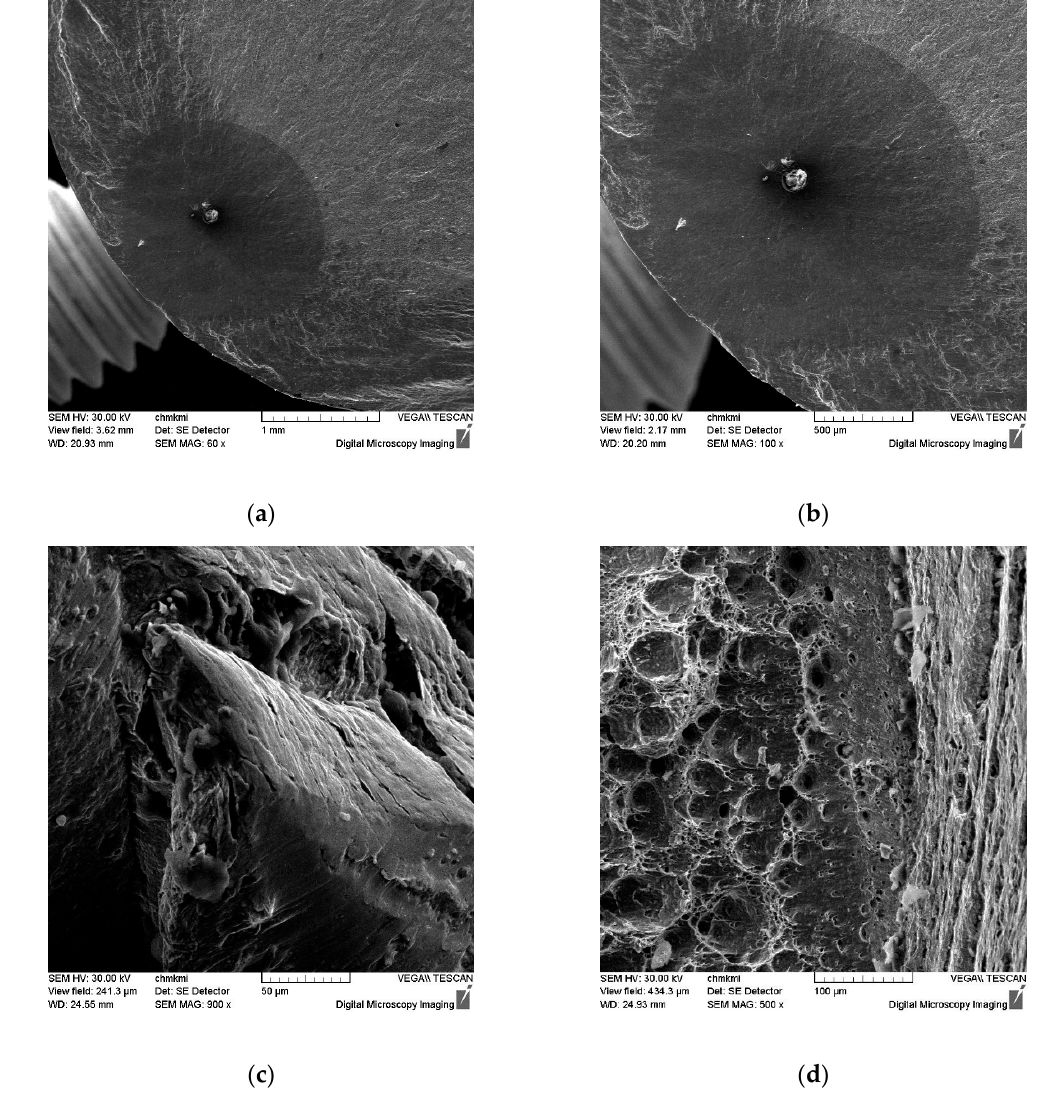
Figure 13. Fracture surface of UIP 85N Strenx 700 MC specimen loaded at 415 MPa and fractured after 5.8 × 10 6 cycles: Overall view of the fracture ( a ), detail of fish-eye fatigue crack initiation ( b ), delamination of the strengthened surface layer ( c ) and final fracture with area of finer dimples in the strengthened surface layer ( d ).